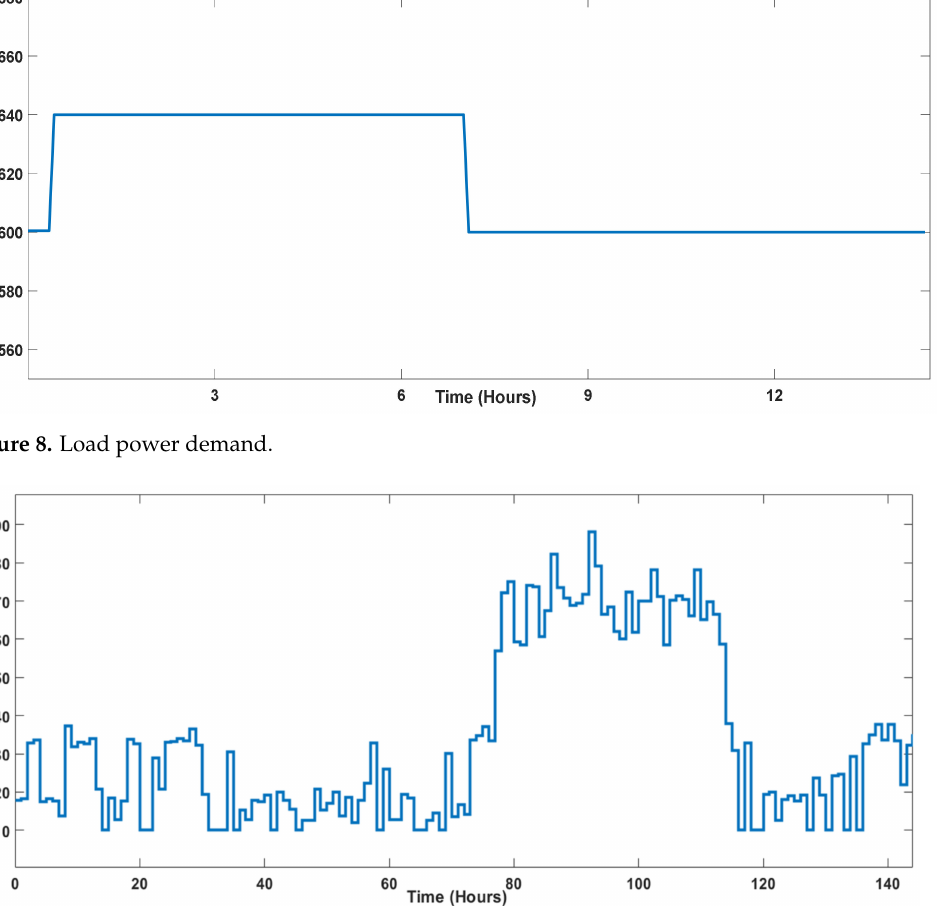
Figure 9. Simulated output power of the wind farm for practical